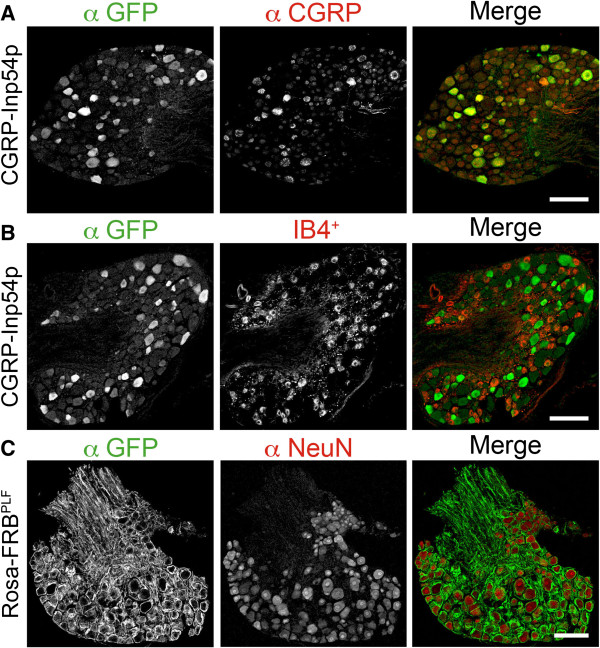
CGRP-Inp54p and Rosa-FRBPLF knockin mice successfully target their respective knockin proteins in DRG neurons. Sections from lumbar DRG from A,B) CGRP-Inp54p+/− knockin mouse stained with antibodies to GFP (cross-reacts with Venus and CFP), CGRP and fluorescent IB4-binding. Venus-FKBP12-Inp54p was confined to cell bodies of CGRP+ neurons. C) FRBPLF-CFP mouse stained with antibodies to GFP and the pan-neuronal marker NeuN. FRBPLF-CFP was localized to the membrane and axons of all neurons. Representative of two animals per condition. Scale bar, 100 μm.